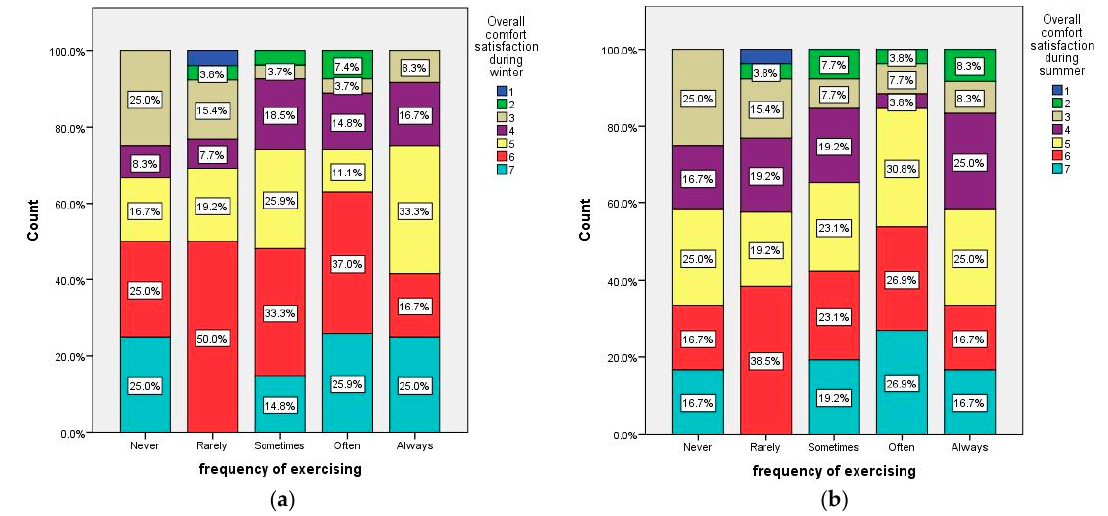
Figure 14. Relation among frequency of exercising by occupants and the overall comfort satisfaction during ( a ) winter and ( b ) summer.